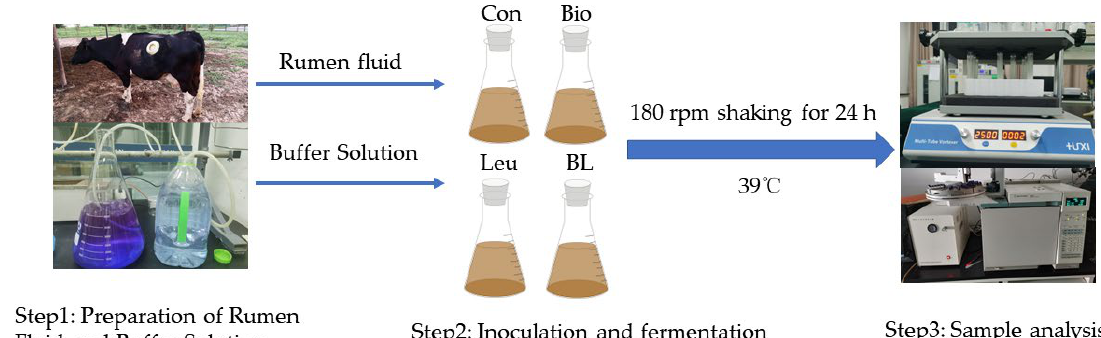
Figure 1. The workflow and experiment design of this study. Con, the control group that only provided the basal diet; Bio, basal diet supplemented with biotin (4 mg/kg dry matter); Leu, basal diet supplemented with biotin (4 g/kg dry matter); BL, combination of biotin (4 mg/kg dry matter) and leucine (4 g/kg dry matter); Each treatment contained five replicates (flasks) and the experiment was repeated twice. Table 1. Ingredients and chemical compositions of TMR diets used for substrate.